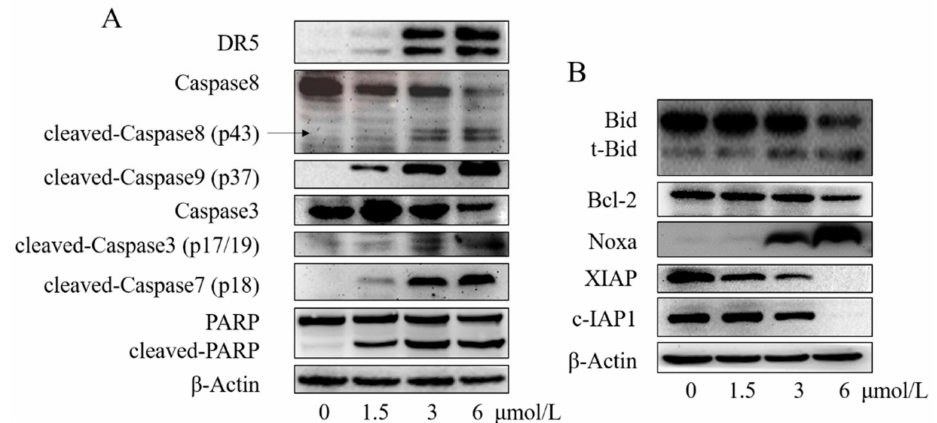
Figure 7. Compound 13e regulated apoptosis related proteins . ( A , B ) The expression of cell apoptosis related proteins were detected by western blotting. MGC-803 cells were incubated with various concentrations compound 13e (0 µ mol / L, 1.5 µ mol / L, 3 µ mol / L, 6 µ mol / L) for 48 h. Date are represented as mean ± SD of three independent